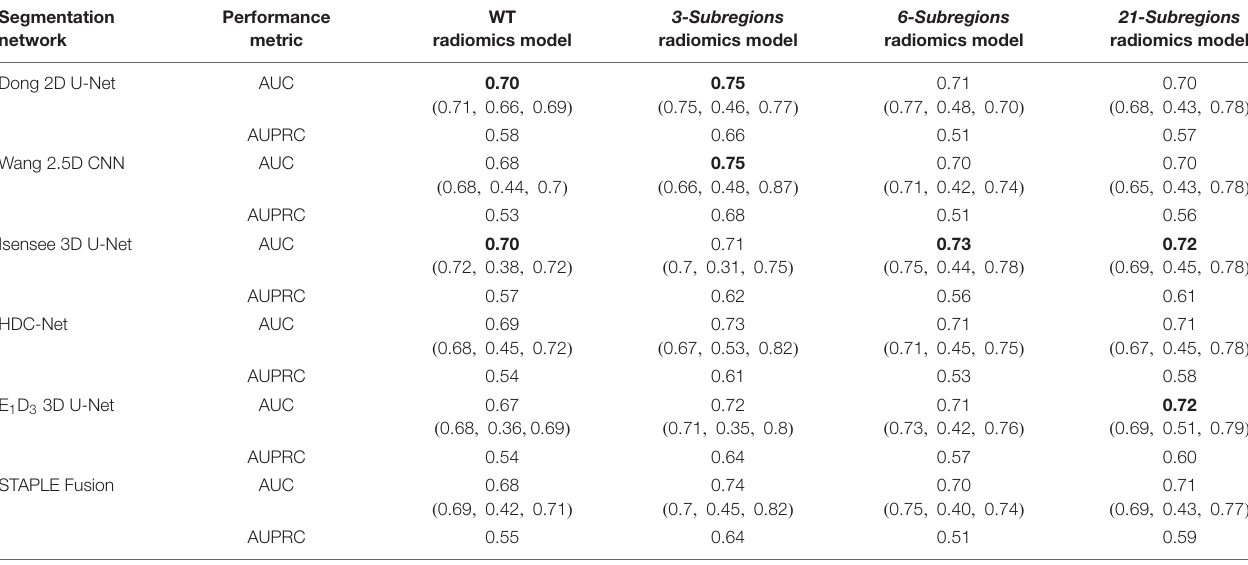
TABLE 5 | Quantitative analysis of four radiomic models, namely, the WT radiomics model, the 3-subregions radiomics model, the 6-subregions radiomics model, and the 21-subregions radiomics model on testing cohort A (31 subjects). Segmentation